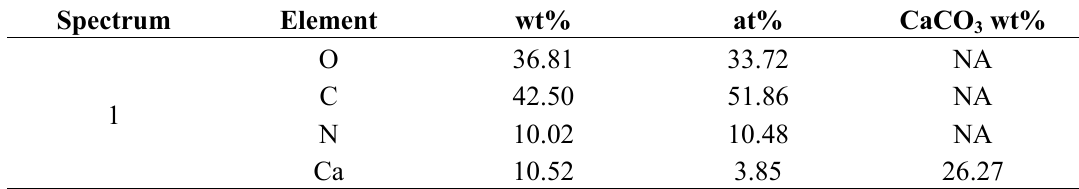
Table 3. X-ray EDS spectra data of INI kenaf bast